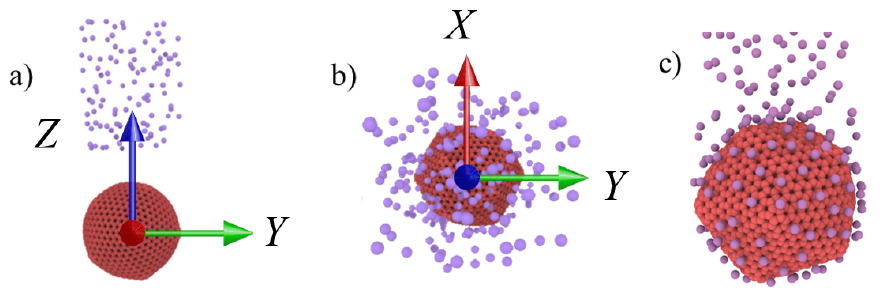
Figure 1. ( a ) Front view of the model. ( b ) Top view of the model. ( c ) Multilayer fullerenes adsorb moving lithium ions.